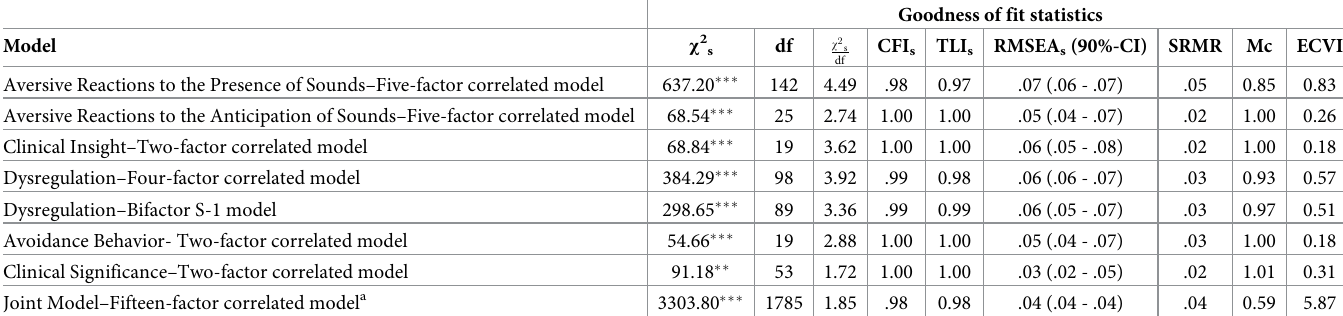
Table 2. Results of confirmatory factor analyses for the symptom part of the BMQ-R. Model